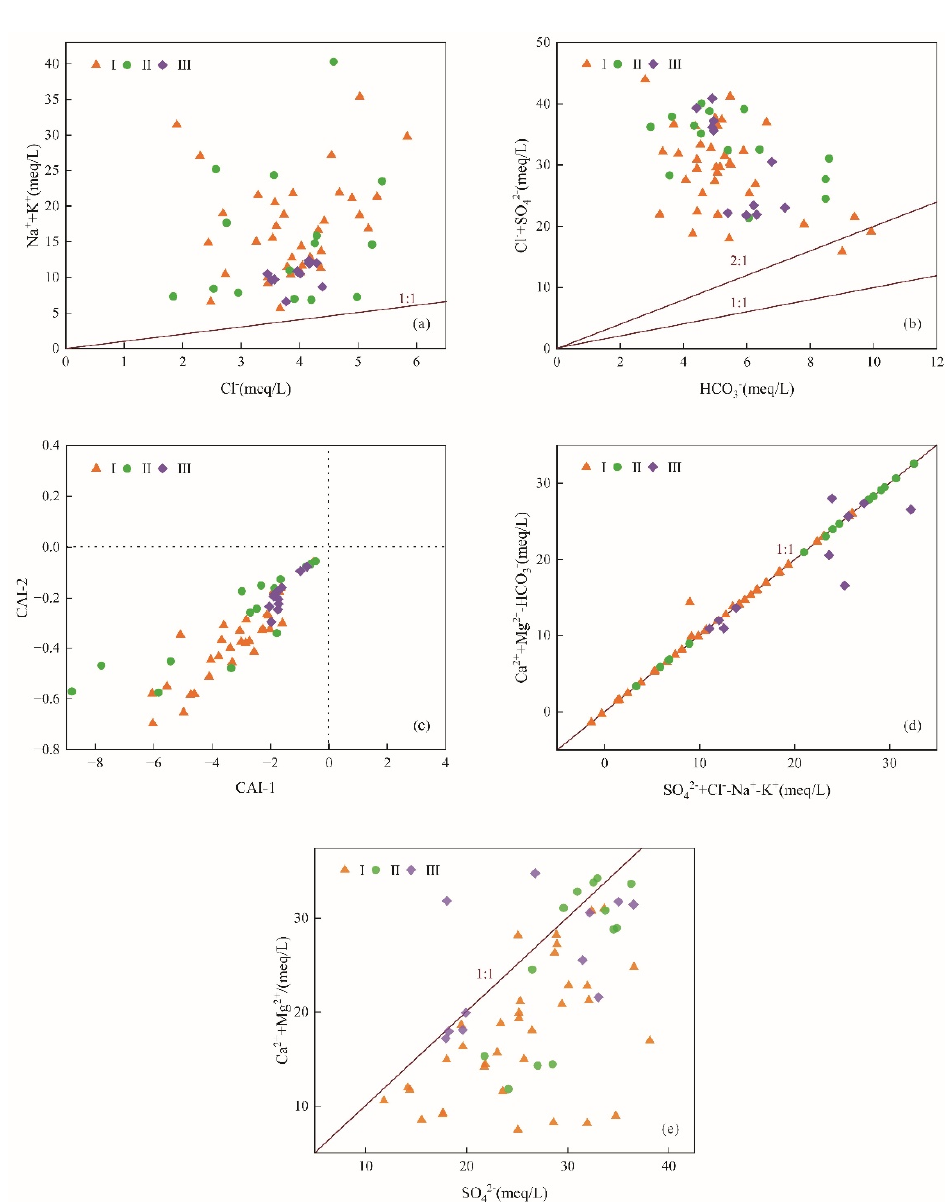
Figure 8. Molar ratio diagram of main ions in karst groundwater. Plots of ( a ): (Na + +K + ) versus Cl − ; ( b ): (Cl − +SO 42 − ) versus HCO 3 − ; ( c ): CAI-2 versus CAI-1; ( d ): (Ca 2+ +Mg 2+ -HCO 3 − ) versus (SO 42 − +Cl − -Na + -K + ); ( e ): Ca 2+ +Mg 2+ versus SO 42 − .